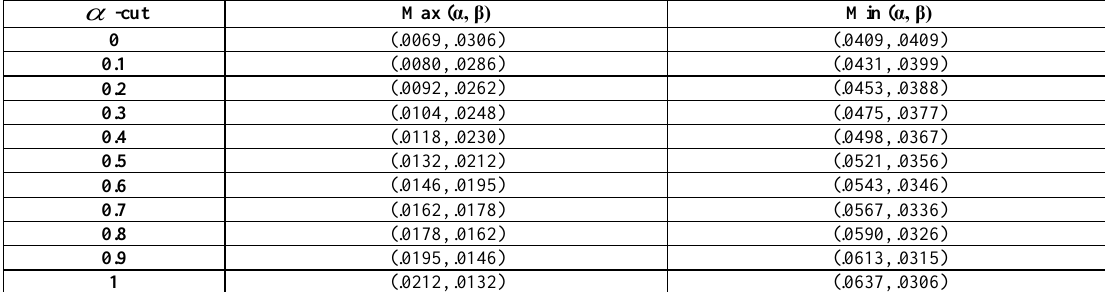
Table 6. Reliability of the circular